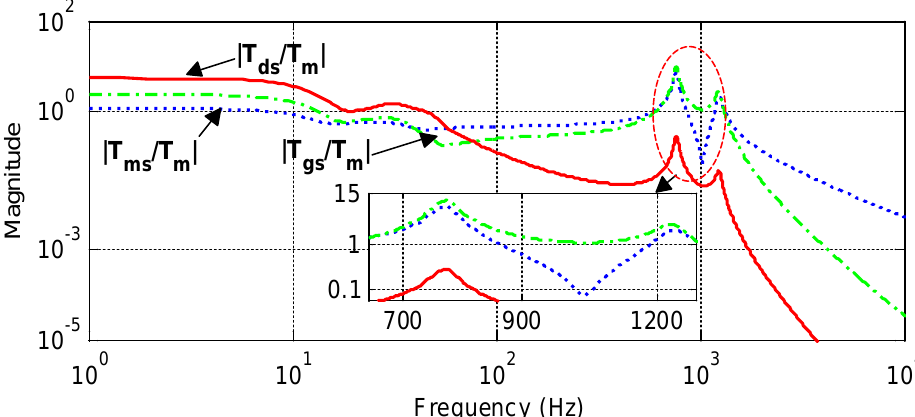
Figure 22. Frequency response of torque of driveline components with input of motor torque.